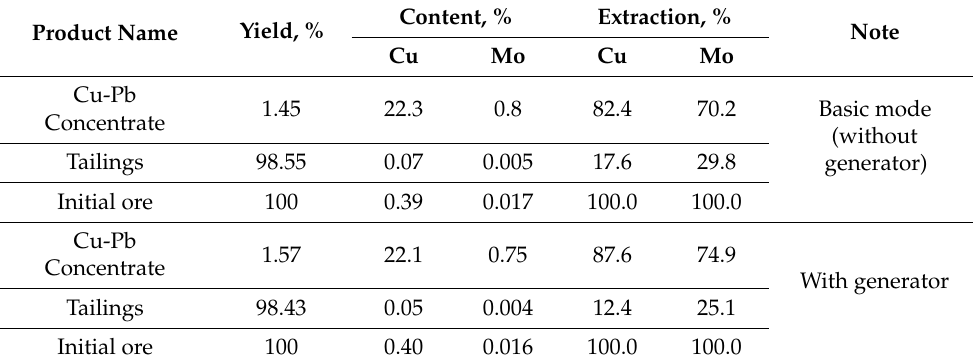
Table 7. Copper-molybdenum rougherflotation results inthe basic mode and with the WAME generator